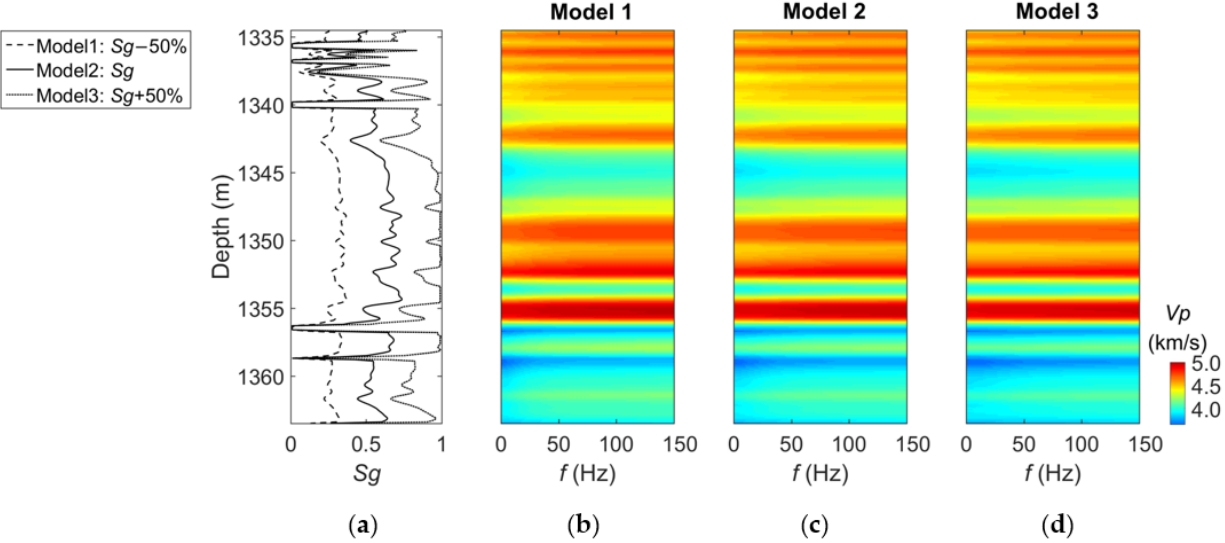
Figure 6. ( a ) Three tight gas sandstone models where S g has change rates of − 50%, 0%, and +50% with respect to original S g logging in Figure 5, and ( b – d ) P ‐ wave velocity dispersion for the three models computed with the proposed model.